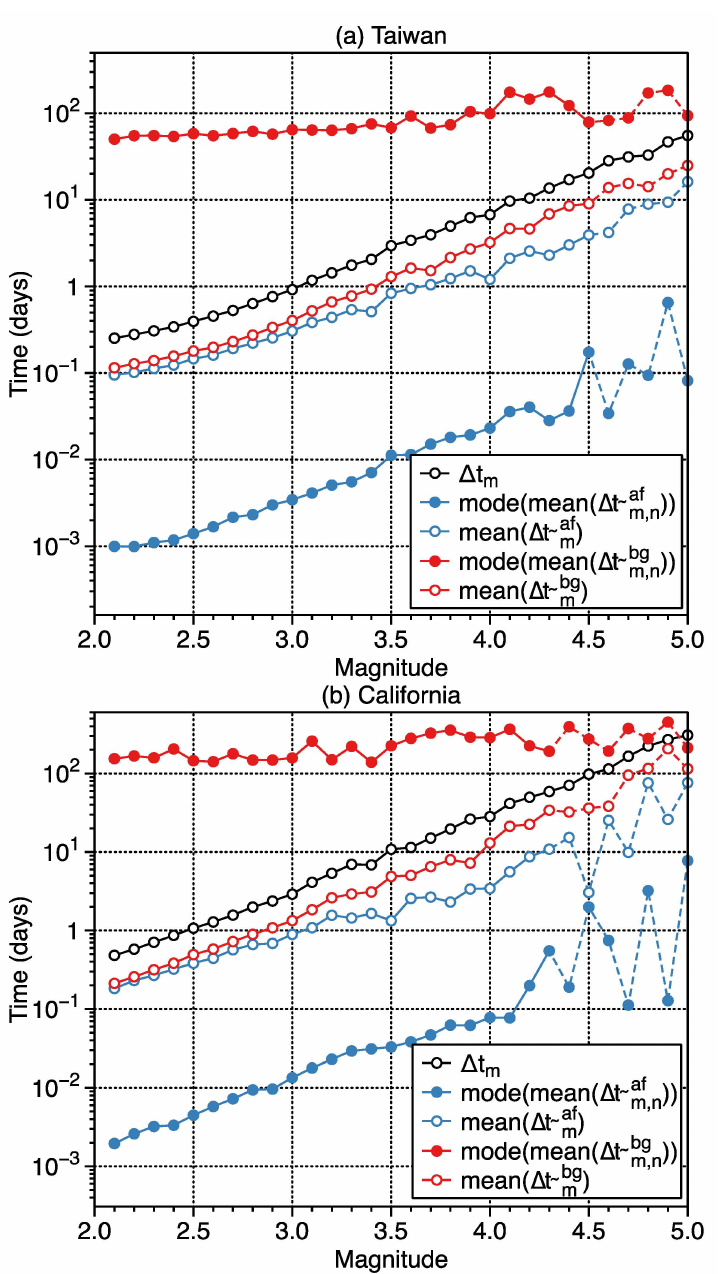
Figure 7. The relationship between event size and the interevent time. The black line shows the average interevent time of all events in the corresponding magnitude bin. The blue lines with solid points and open points represent the interevent time of the aftershocks discriminated from k-means without and with assigning the average interevent time as the time window in the network distance calculation, respectively. The red lines represent the results for background